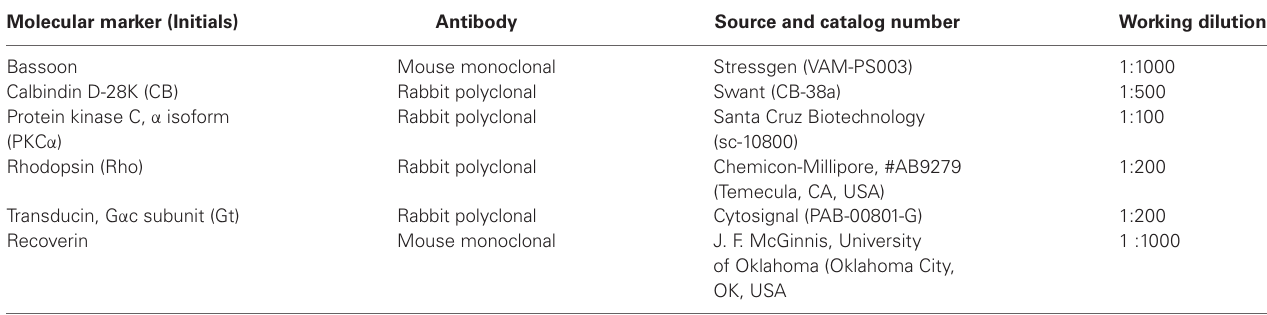
Table 1 | Primary antibodies .